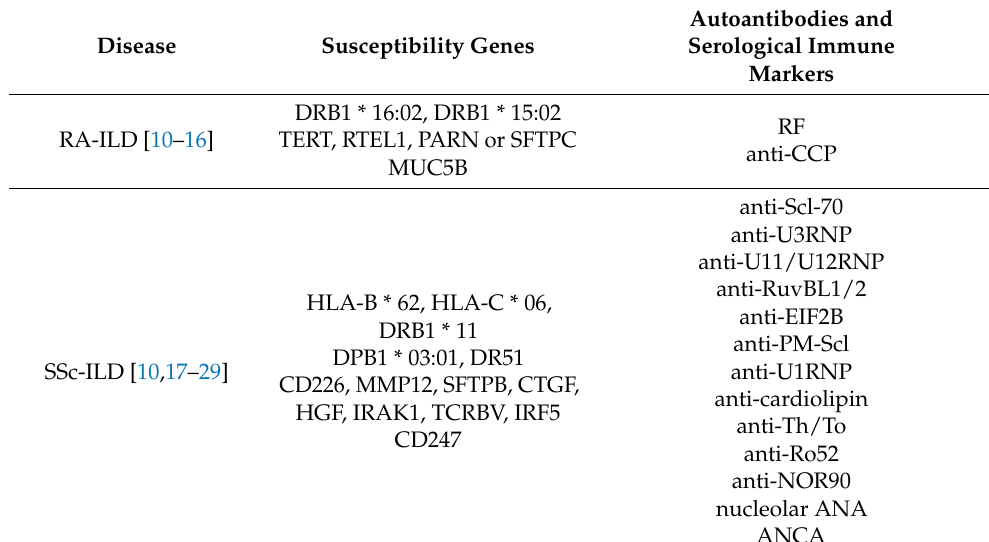
Table 5. Susceptibility genes, autoantibodies, and serological immune markers associated with